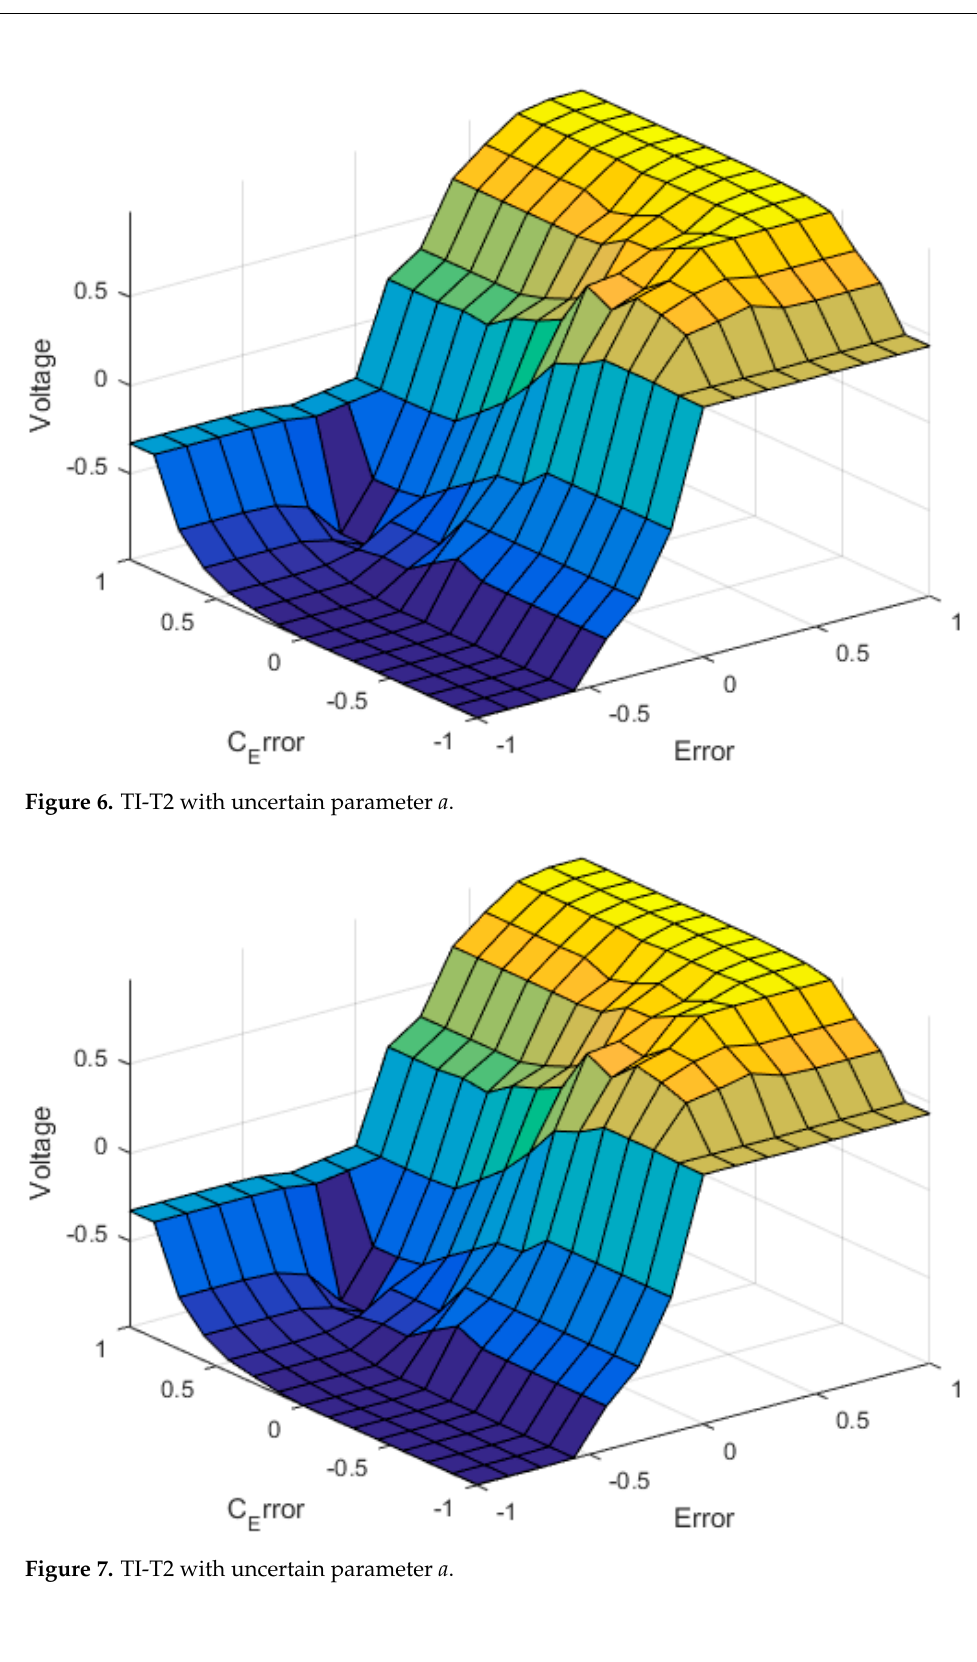
Figure 6. IT-T2 with uncertain parameter 𝑎 .